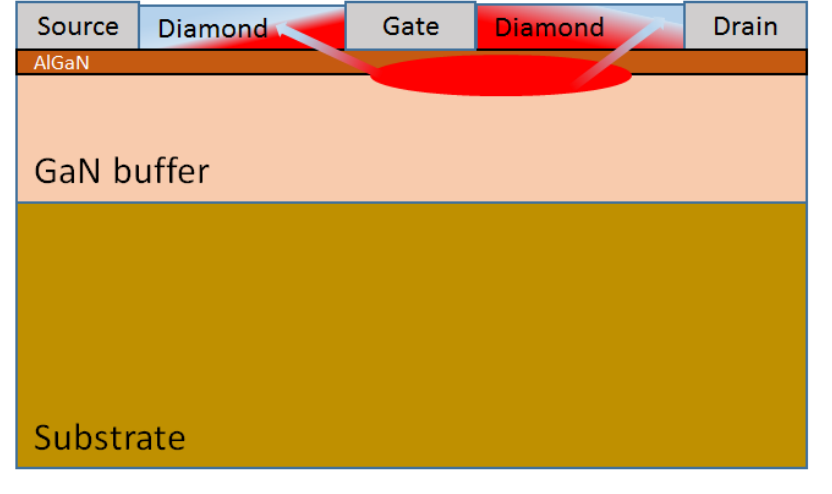
Figure 14. Capping diamond concept.